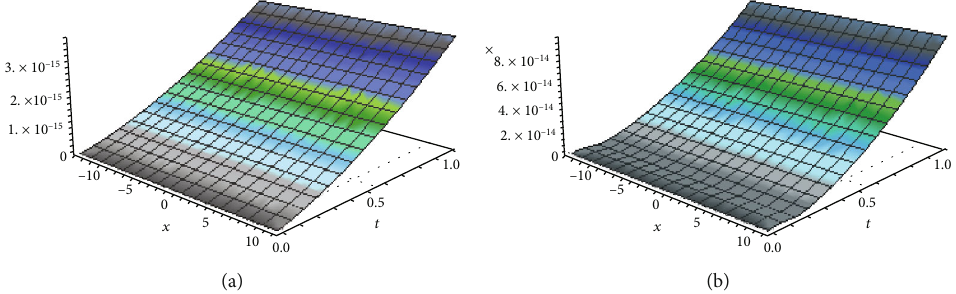
Figure 8: Surface of absolute error for FCH6 model (72) and (73) at μ = 0 : 01 and α = 0 : 75 : (a) j u